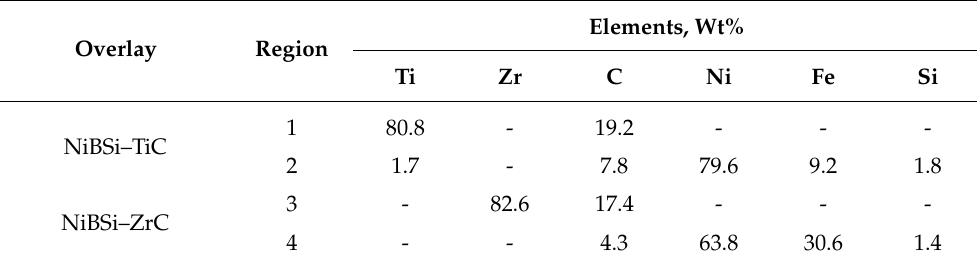
Table 5. Point EDS analysis of nickel alloy–TiC and –ZrC regions indicated in Figures 7a and 8a.